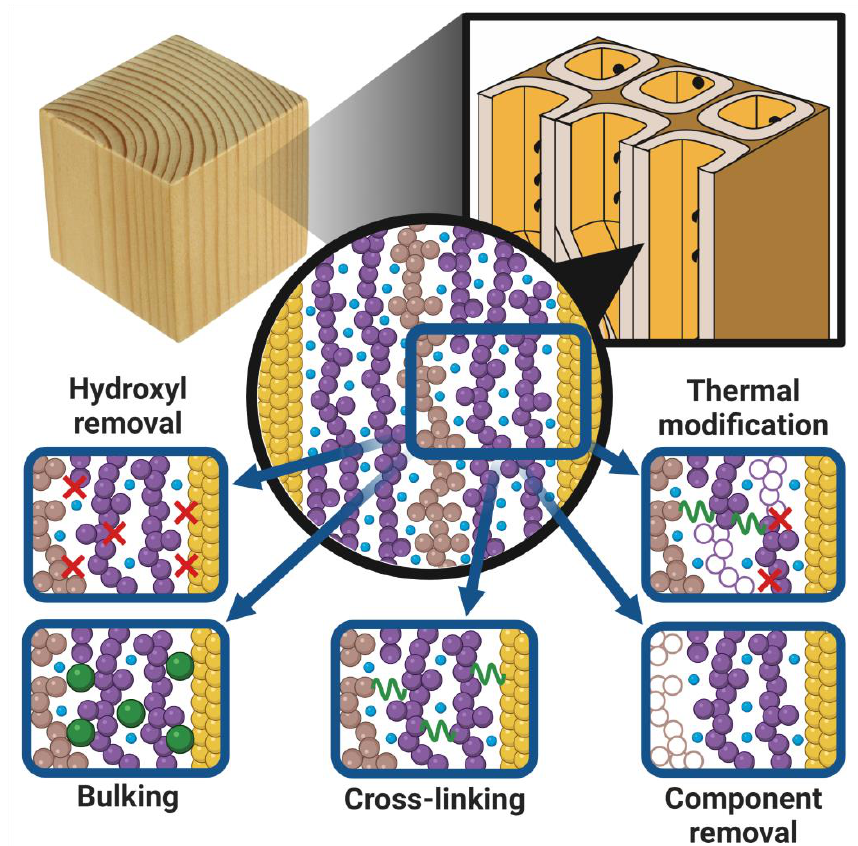
Figure 4. Types of wood modifications affecting the cellulose (yellow), hemicelluloses (purple), and lignin (brown) of the cell wall material as well as the interactions with water (blue spheres). Hydroxyl removal reduces the number of hydroxyls (OH); bulking adds volume within cell walls; cross-linking covalently joins adjacent wood components; component removal selectively removes or reduces a specific component (here illustrated by delignification, i.e., removal of lignin); and thermal modification involves both component removal (primarily hemicelluloses) and hydroxyl removal, and cross-linking during the treatment.